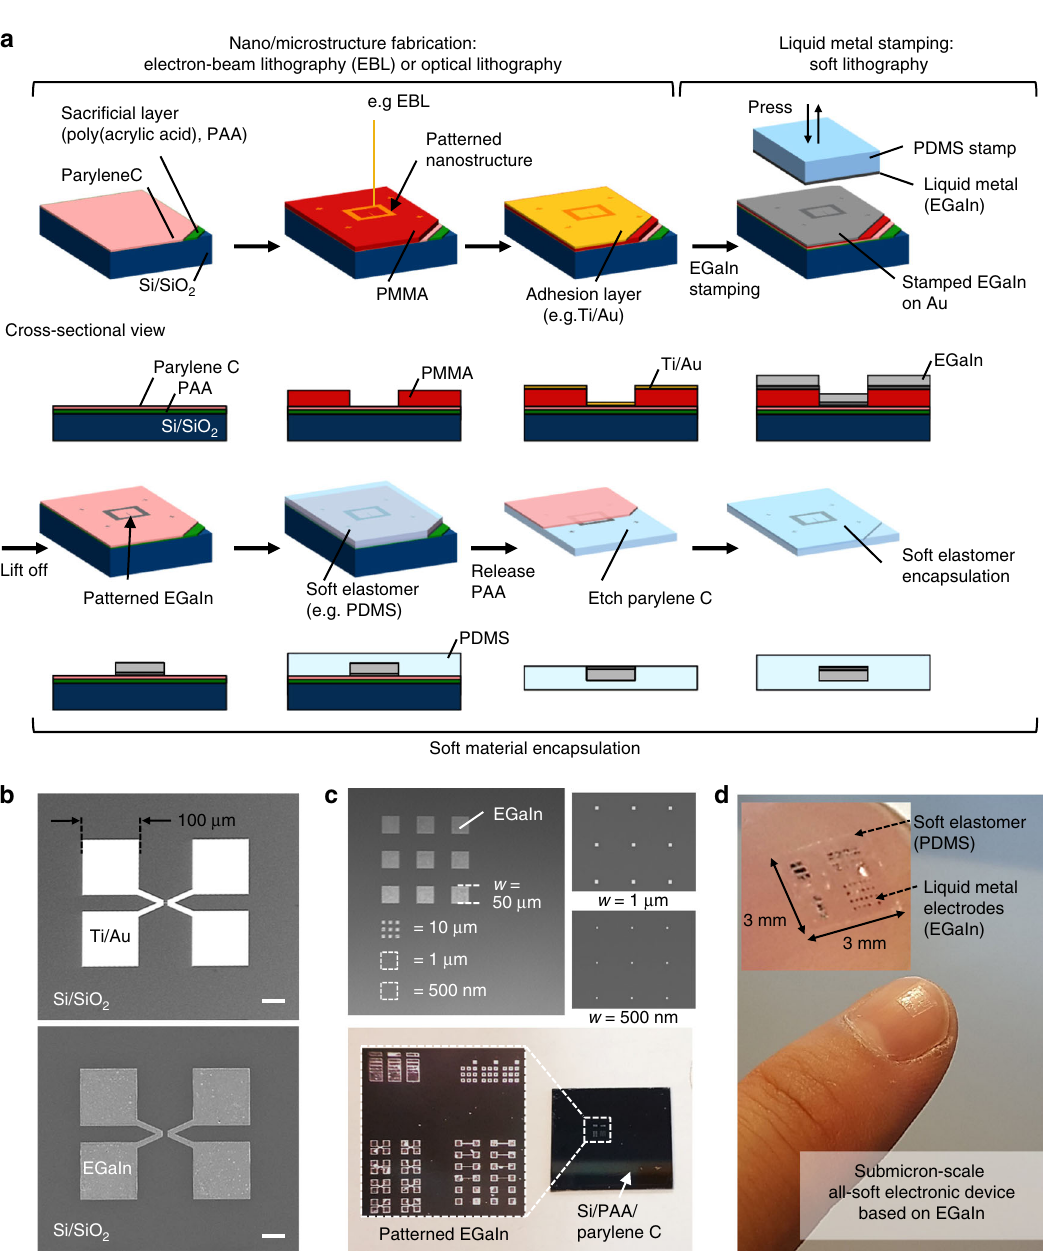
Fig. 1 Nanofabrication process based on hybrid lithography for submicron-scale EGaIn patterning. a Hybrid lithography process combining electron- beam lithography and soft lithography for fabrication of submicron-scale, soft electronic devices based on EGaIn. b Patterned Au (top) and EGaIn on Au (bottom) structures. Scale bars indicate 40 μ m. c Patterned EGaIn square-shaped dot arrays with various dot dimensions from 50 μ m down to 500 nm, and d soft material encapsulation and release process of the EGaIn